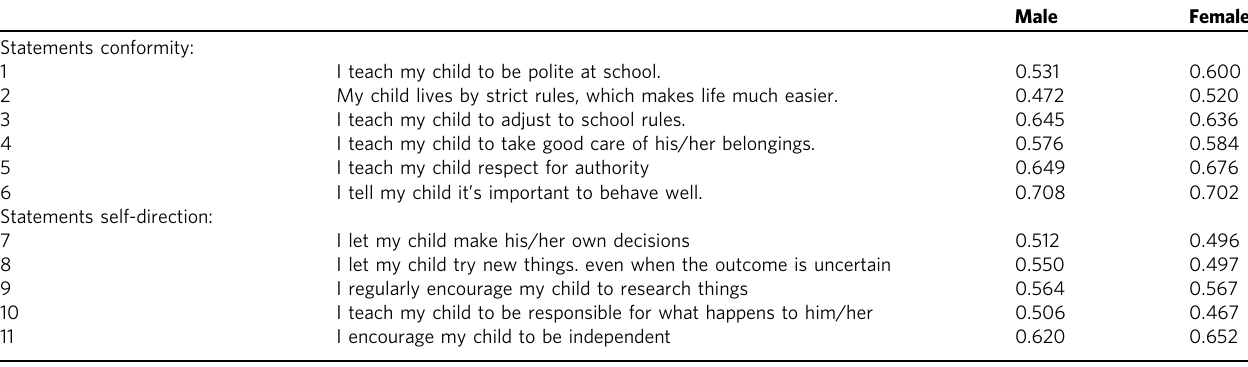
Table 2 Items about parenting values and their factor loadings within the SEM